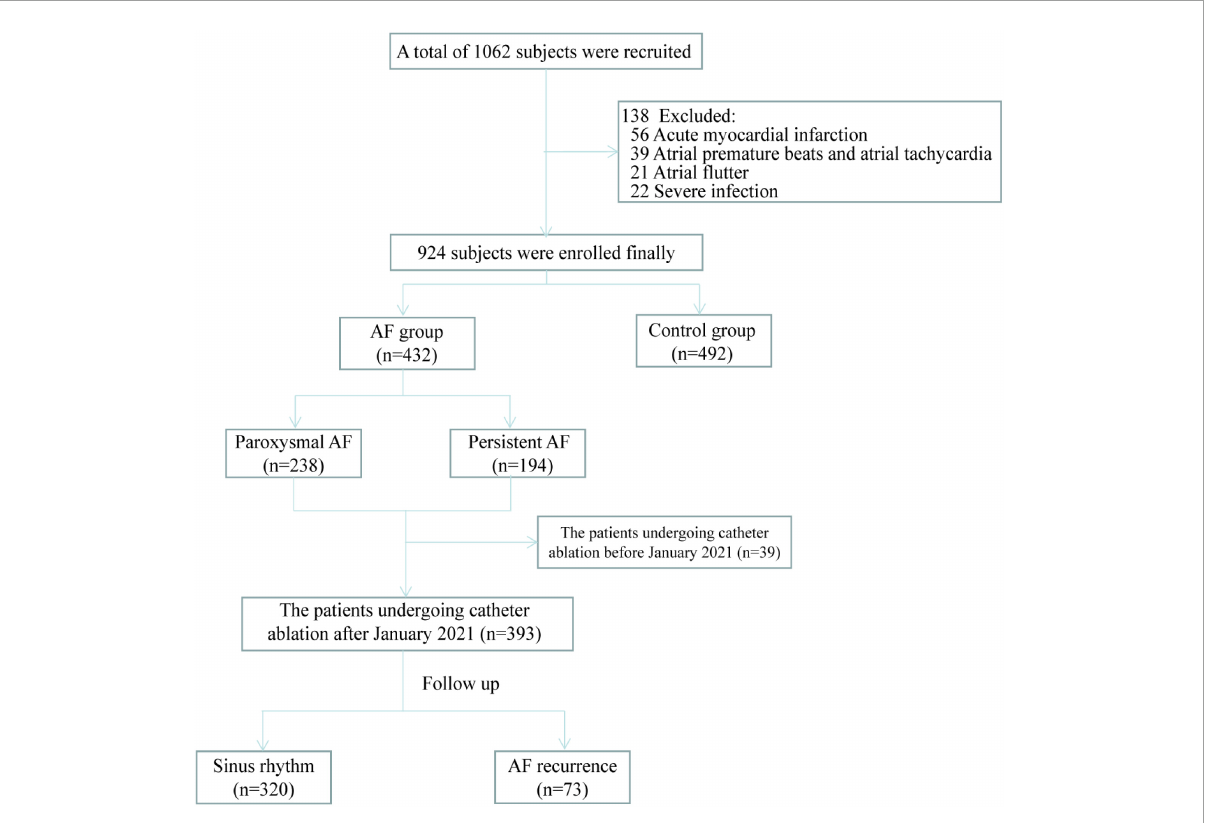
FIGURE1 The study flow diagram for all subjects. Abbreviation. AF, atrial fibrillation.